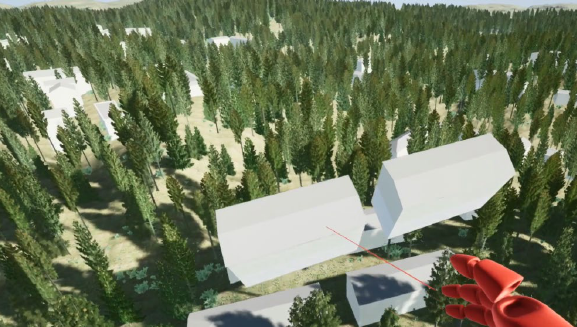
Figure 6 . Moving of buildings in the bird’s-eye view